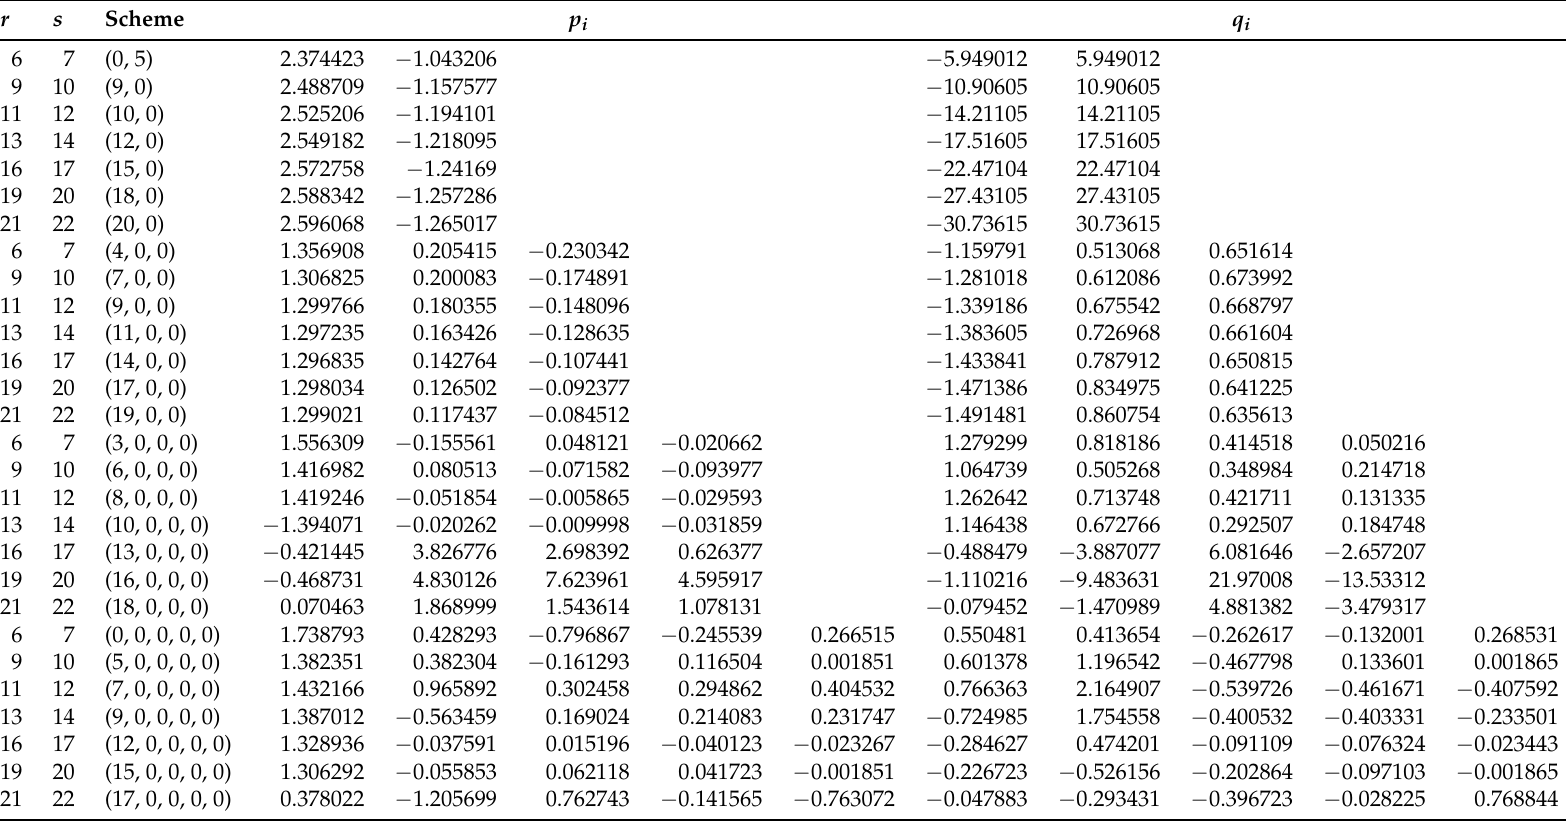
Table 6. Coefficients of the BLUEs for some selected progressive censoring schemes of µ and σ for λ =